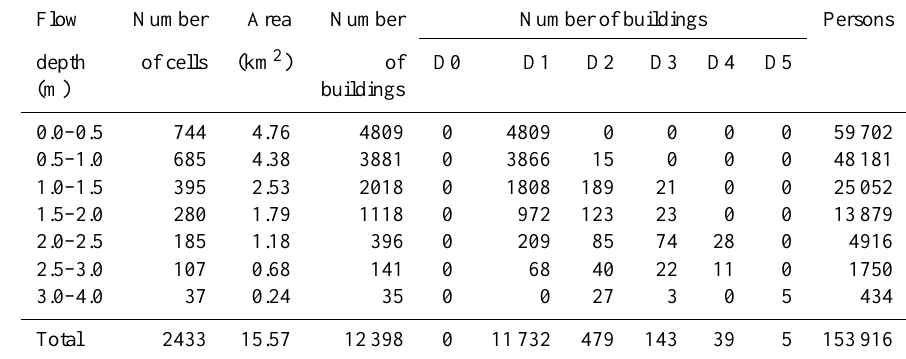
Table 6. Damage to buildings and exposed persons under the hypothesis of mean-sea-level conditions. Flow